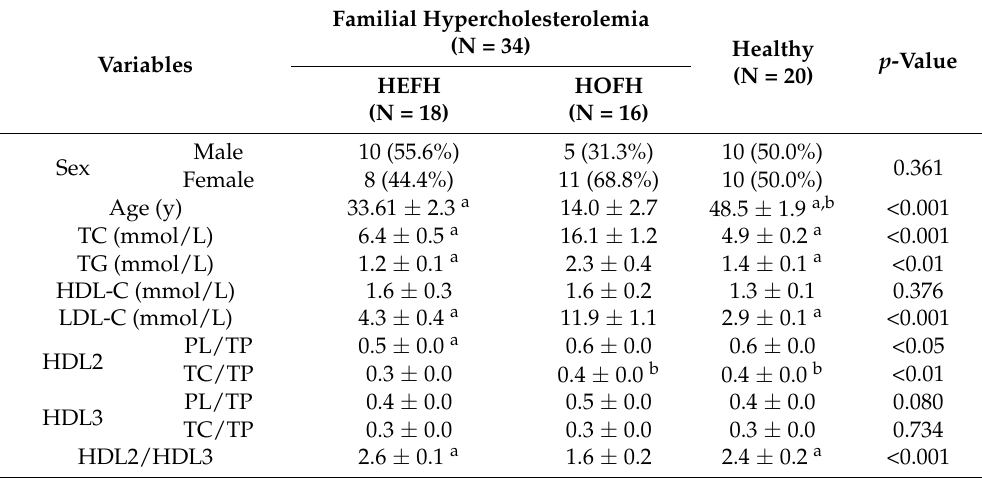
Table 1. Baseline characteristics of the subjects.